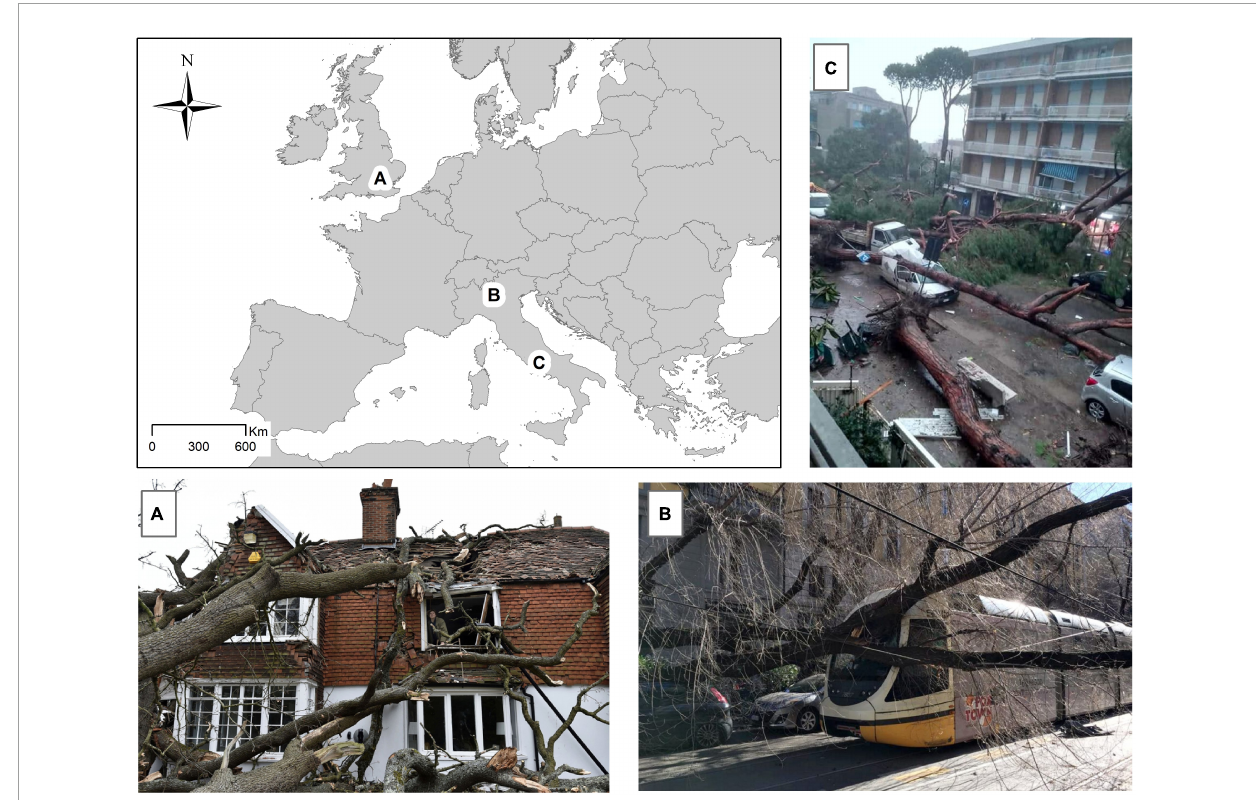
FIGURE3 Different types of disservices caused by falling trees during heavy storms that hit European cities in the last years. (A) Extensive damage caused by a large oak that struck a building after being torn down by storm Eunice on 18 February 2022 in Great Britain (source: https://www.gulftoday.ae/news/ 2022/02/19/14-dead-as-storm-eunice-hits-power-and-transport-in-europe). (B) Public transport service disruption due to a collapsed tree on a tram during the storm of 7 February 2022 in Milan (source: https://tg24.sky.it/cronaca/2022/02/07/vento-milano-danni#23). (C) A road was interrupted and some cars crushed by several pines uprooted by the Adrian cyclone that landed on the Tyrrhenian coastal town of Terracina (Central Italy) on 29 October 2018 (source: